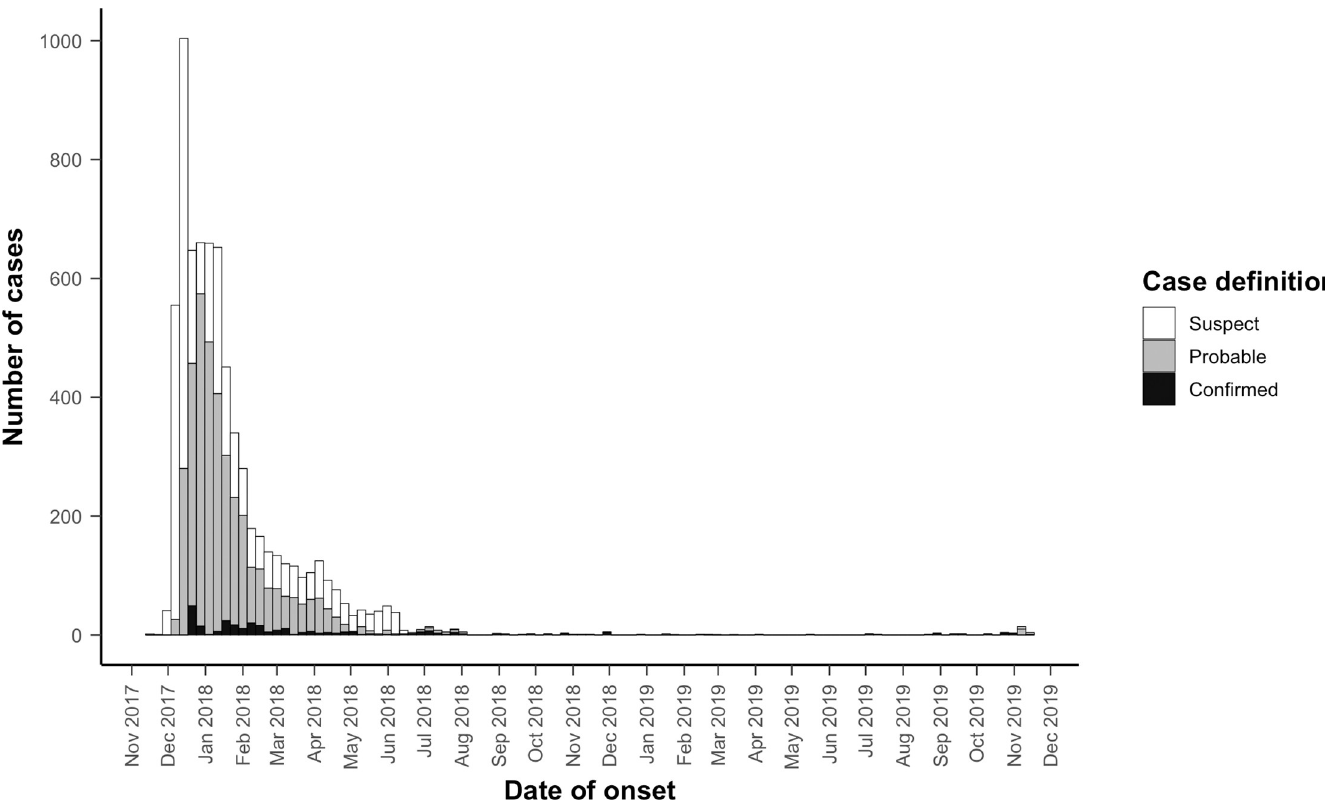
Fig 1. Weekly epidemic curve of diphtheria cases (confirmed, probable, and suspected) among Rohingya refugees, Cox’s Bazar, Bangladesh, November 10, 2017 to November 10, 2019.